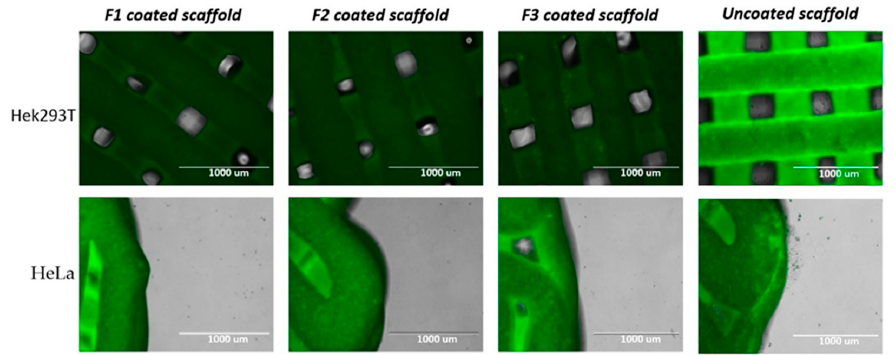
Figure 10. Microscopic images of cell cultured coated and uncoated CPC scaffolds.